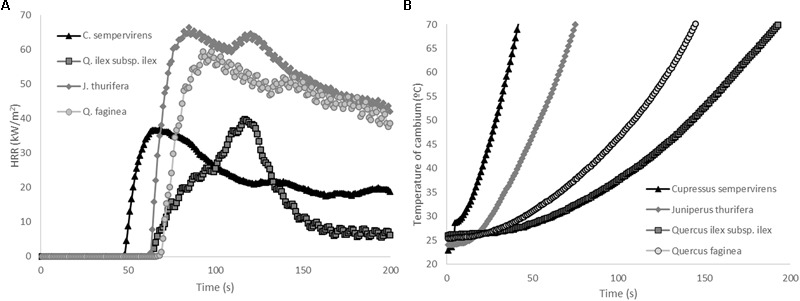
(A) Average heat release rate (HRR) curves (kW/m2) and (B) average temperature increase under the bark (at cambium level) for C. sempervirens, J. thurifera, Q. ilex, and Q. faginea (MLC tests, radiant heat flux 25 kW/m2).